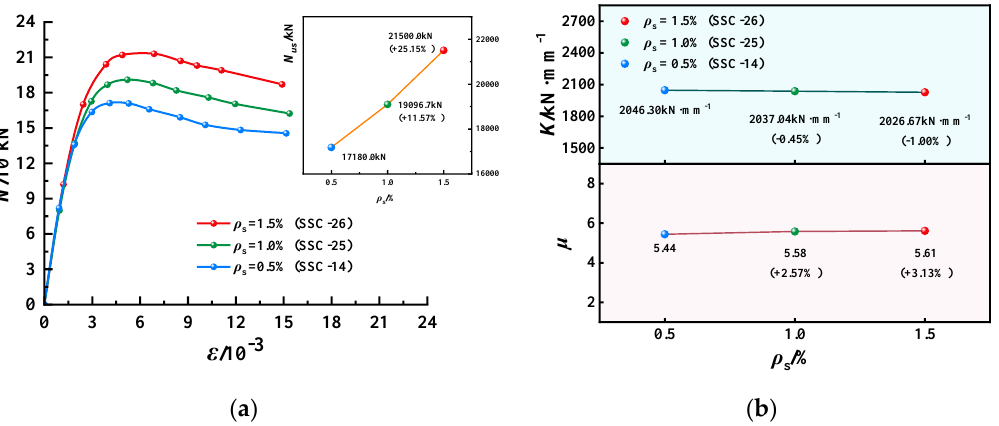
Figure 16. N - ε curves, K and µ of EGCSSCs with different ρ s : ( a ) N - ε curves of specimens with cross-section height of 1000 mm. ( b ) K and µ of specimens with cross-section height of 1000 mm.